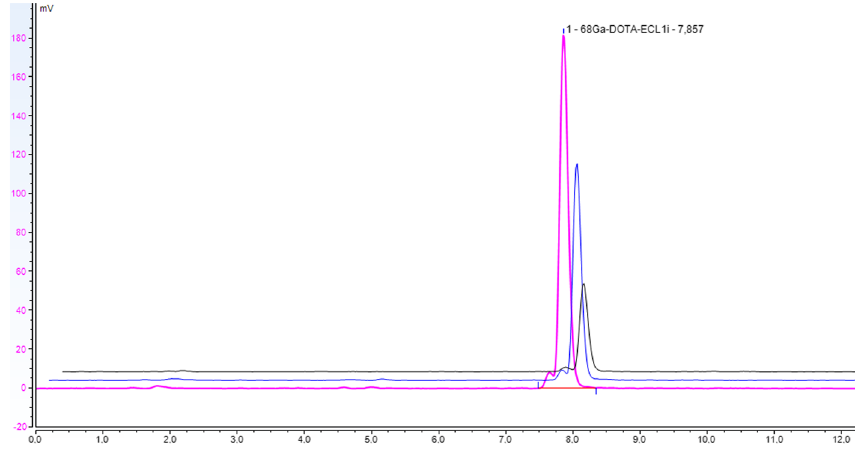
Fig. 3 Stability of [68Ga]68Ga-DOTA-ECL1 (pink dash: 1 h, blue dash: 2 h, black dash: 3 h)